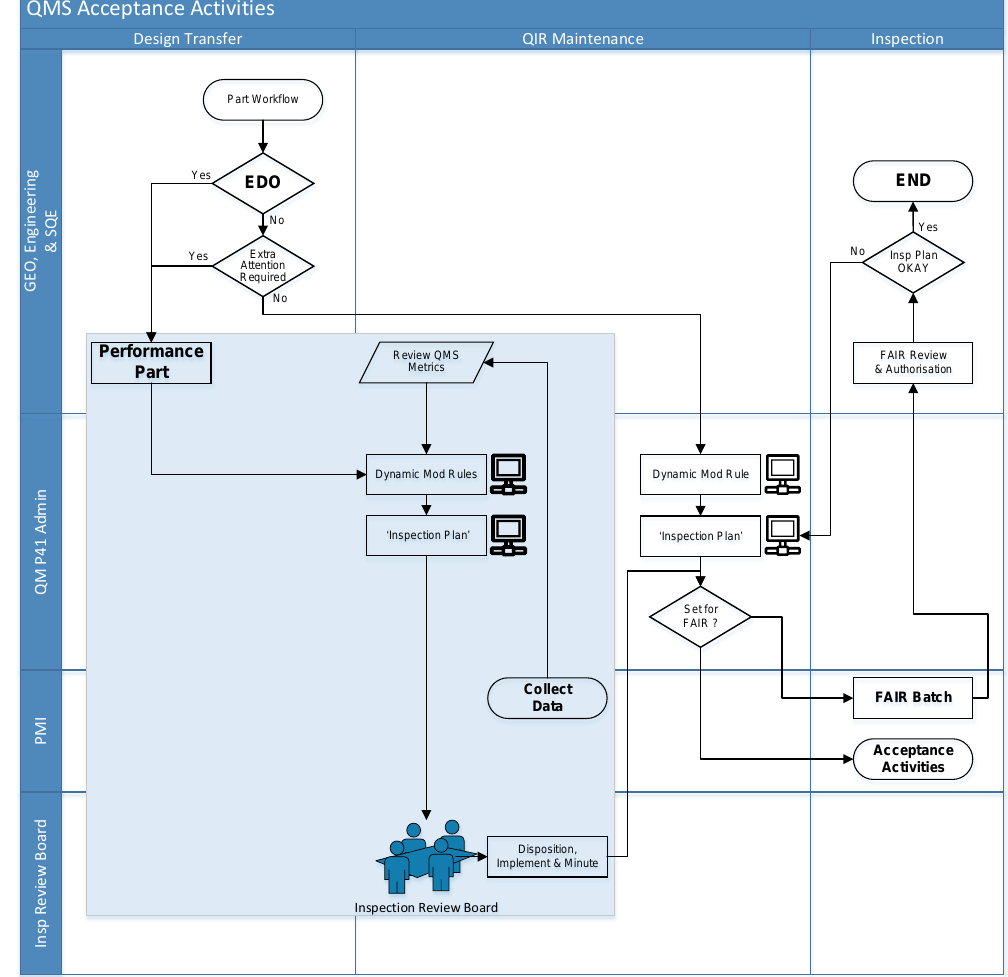
Figure 3. QMS acceptance activities for performance parts.